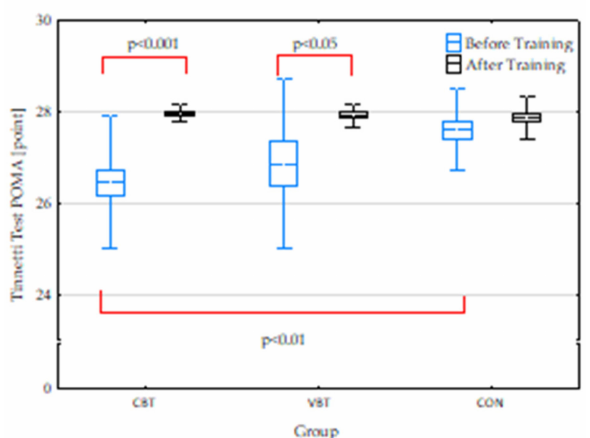
Figure2. Tinetti(POMA)resultsbeforeandaftercompletionof12-weekbalancetraining. Presentationof individual data, mean (—), SEM (box), and SD (whiskers); CBT—classical balance training,